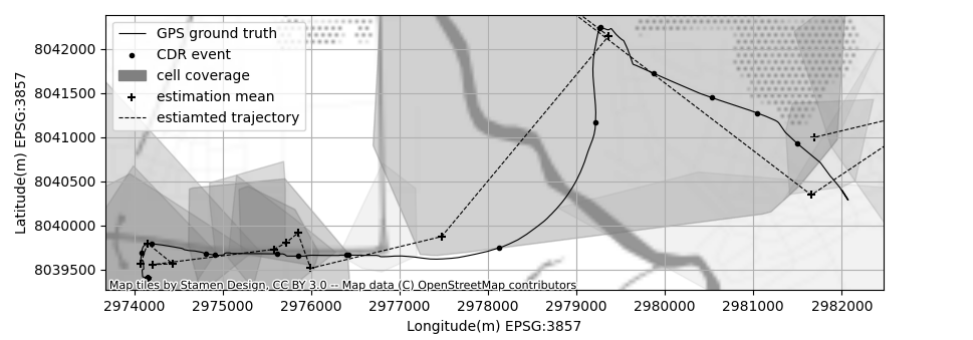
Figure 1. An example of CDR based localization; the method estimates the location based on cell coverage areas using